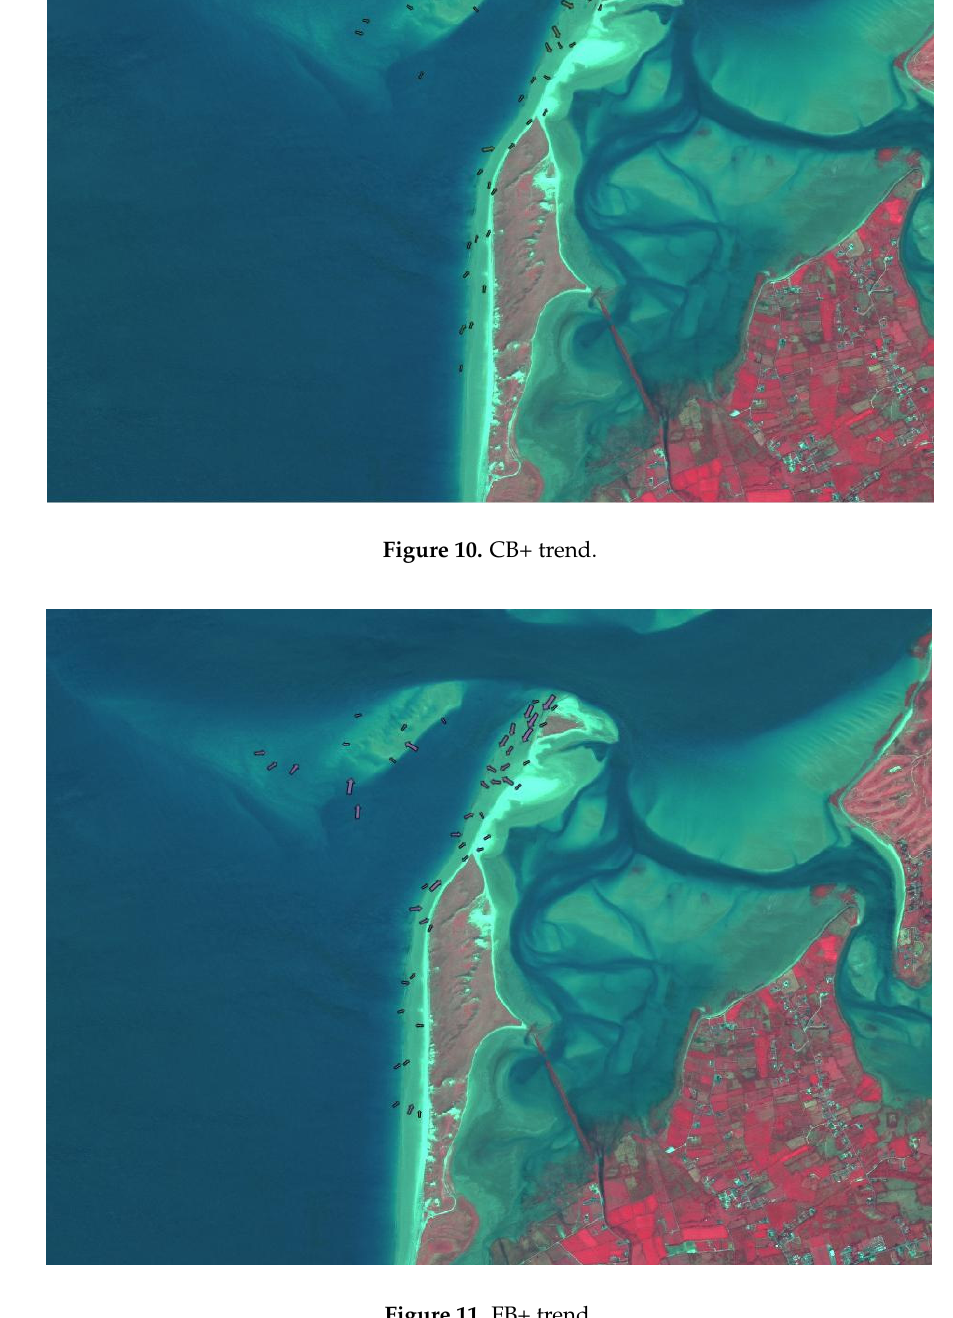
Figure 11. FB+ trend.